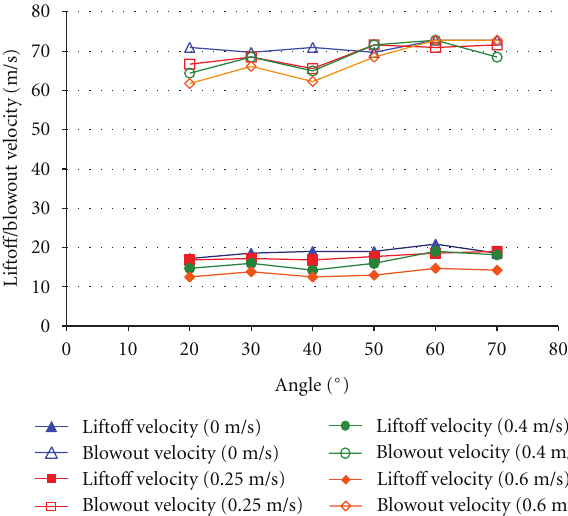
Figure 5: Stability limits versus angle for all coflow velocities.